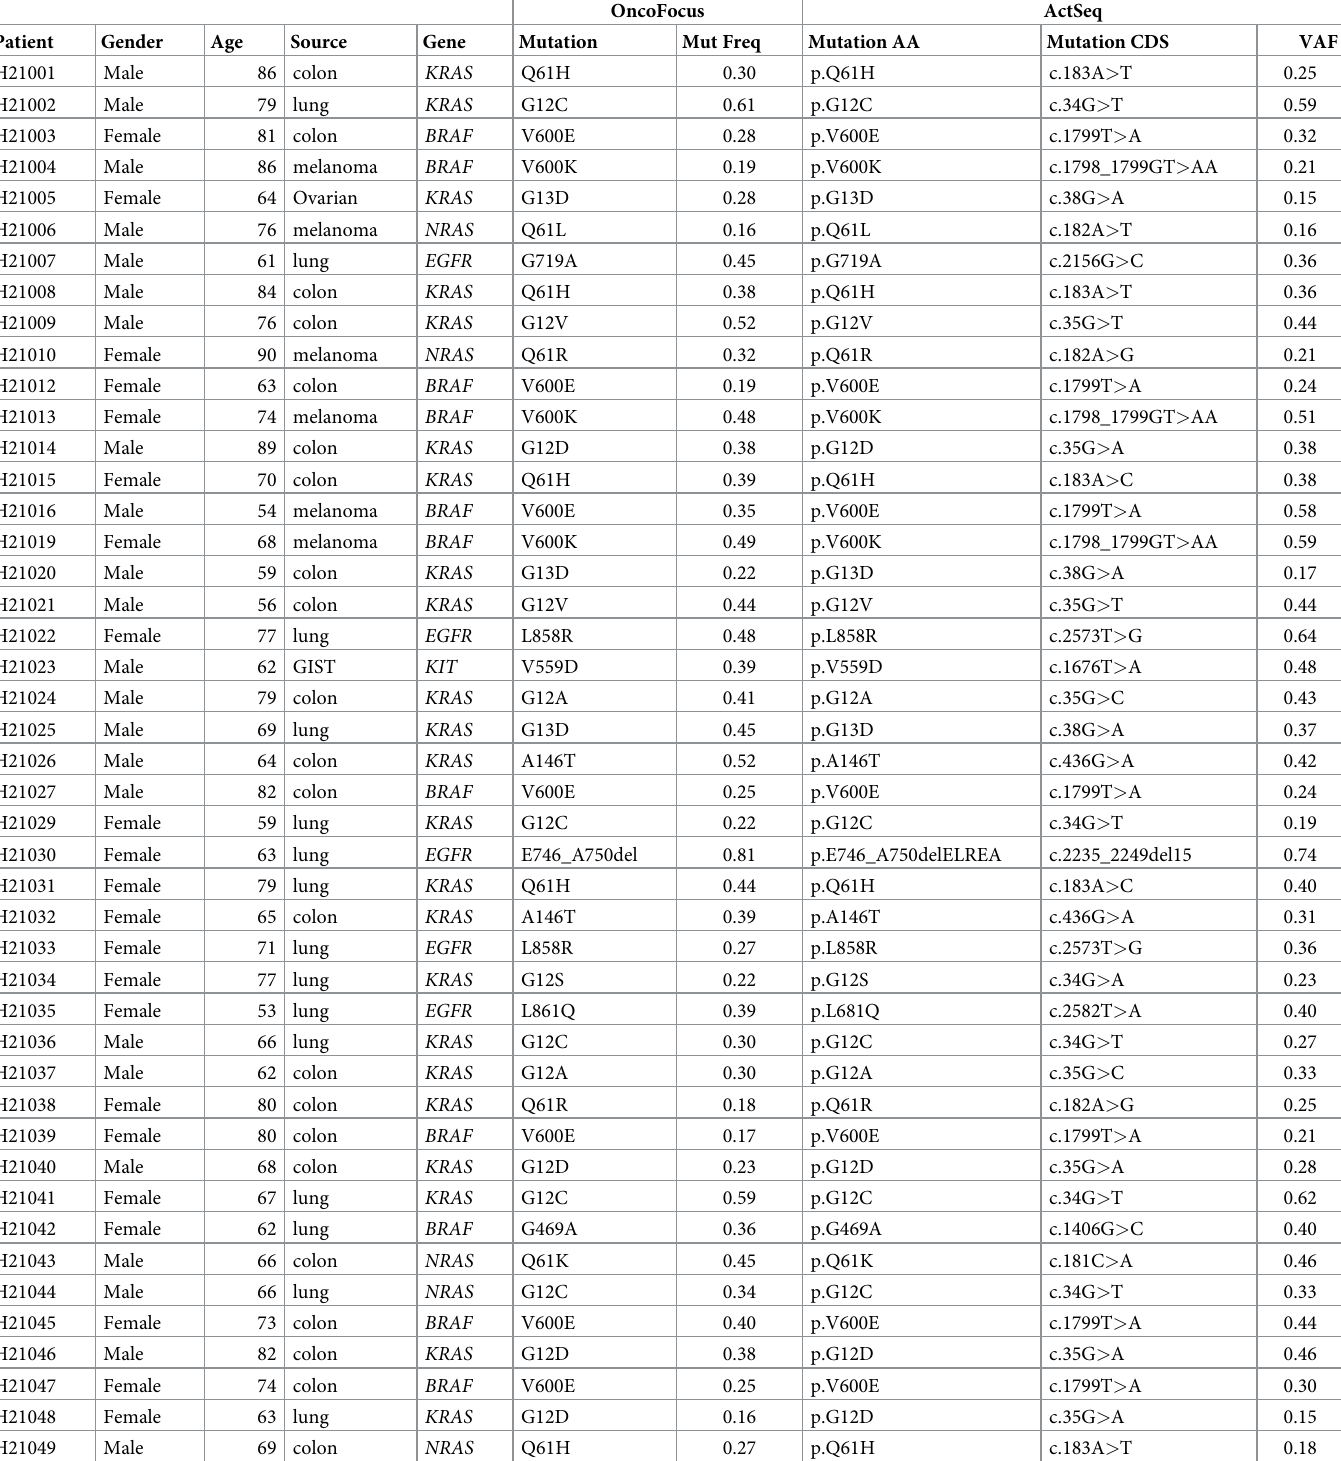
Table 4. Concordance of OncoFocus panel vs ActSeq